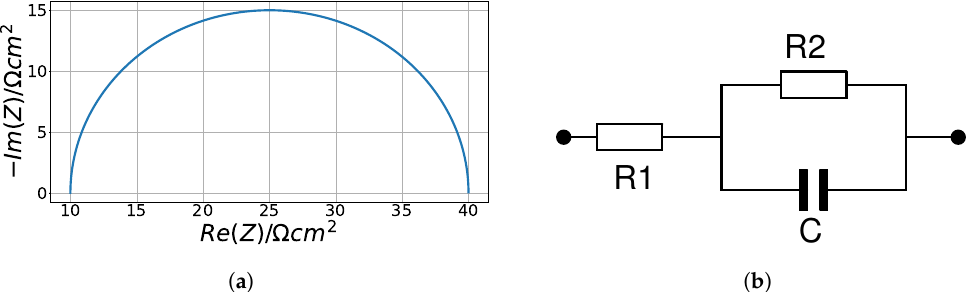
Figure 6. Single ZARC characteristic and its equivalent circuit. ( a ) Z characteristic; ( b ) Equivalent